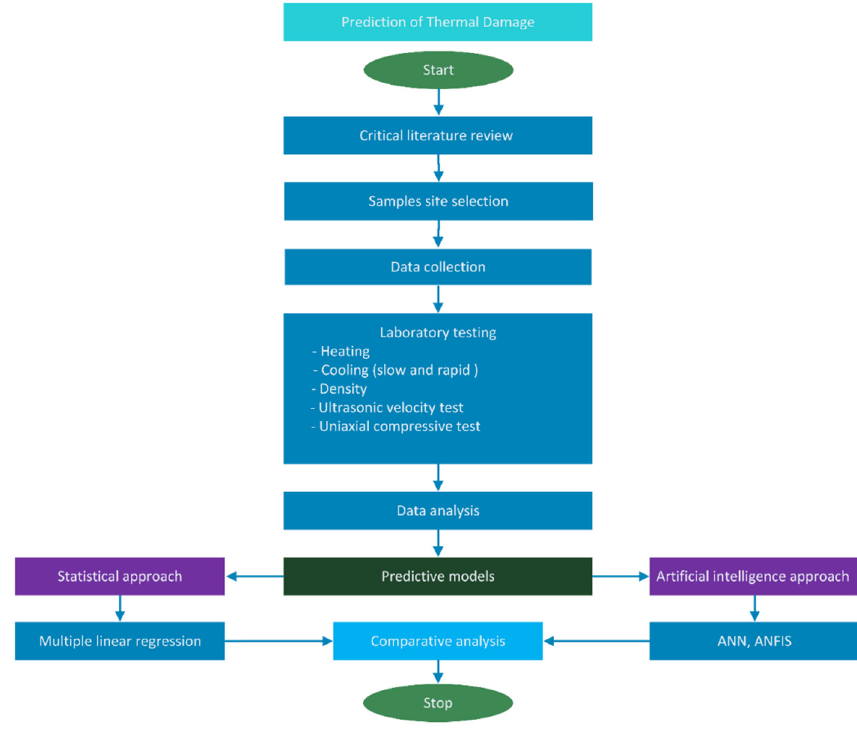
Figure 2. Flowchart of the methodology for the prediction of thermal damage. Table 1. Thermal damage factors under slow cooling and rapid cooling.